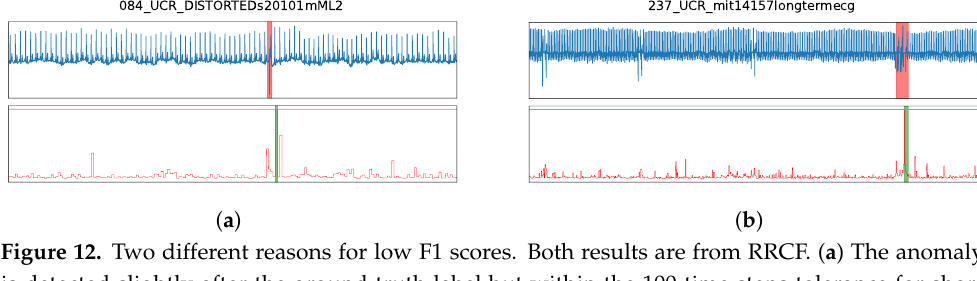
Figure 12. Two different reasons for low F1 scores. Both results are from RRCF. ( a ) The anomaly is detected slightly after the ground truth label but within the 100 time steps tolerance for short anomalies in the UCR score. ( b ) The detected anomaly is shorter than the ground truth label causing false negatives in the computation of the F1